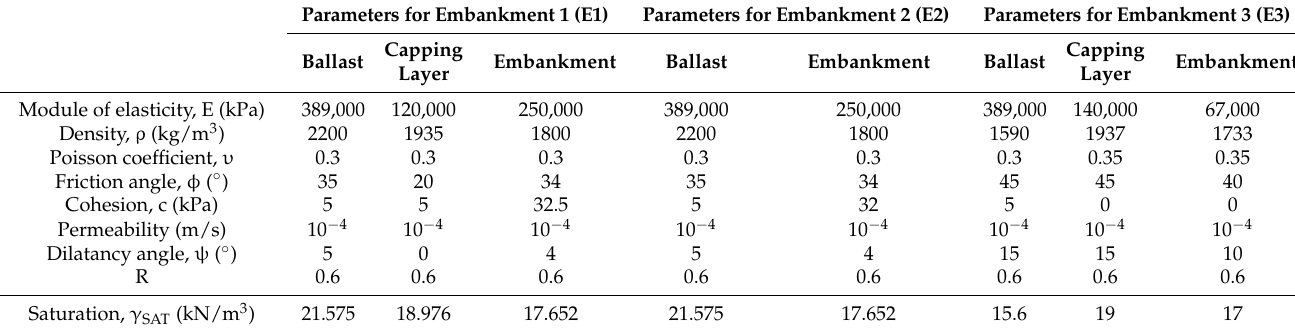
Table 4. Material modeling parameters for embankment’s layers